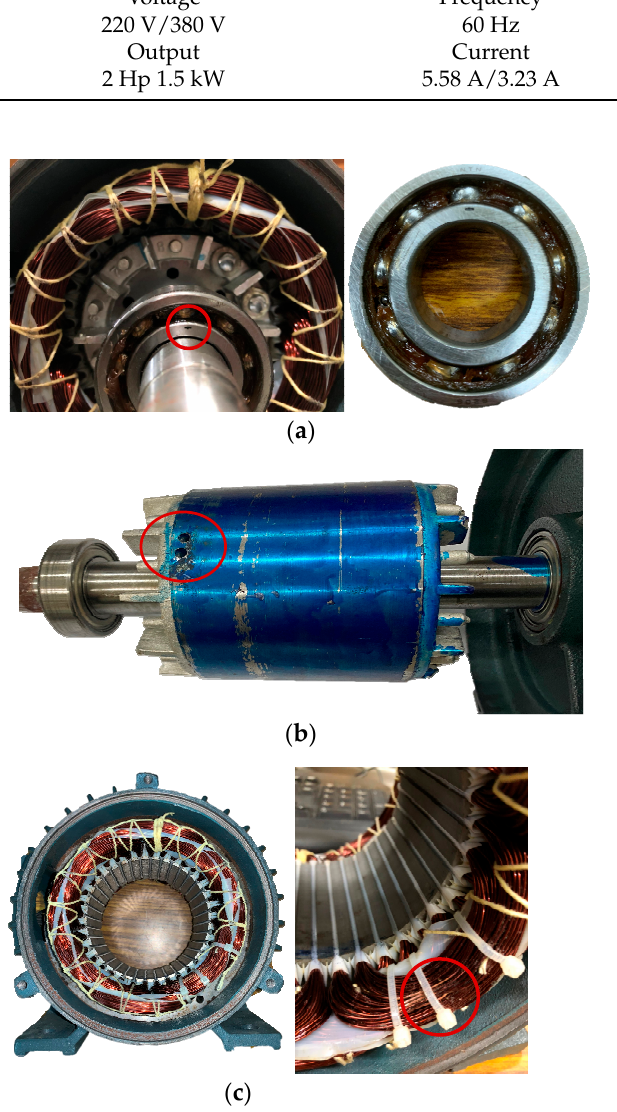
Figure 6. ( a ) Bearing damage processing (aperture 1.96 mm × 0.53 mm). ( b ) Rotor drilling failure (two holes ∮ 8 mm depth 10 mm). ( c ) Short circuit between stator layers (two coils short circuit).